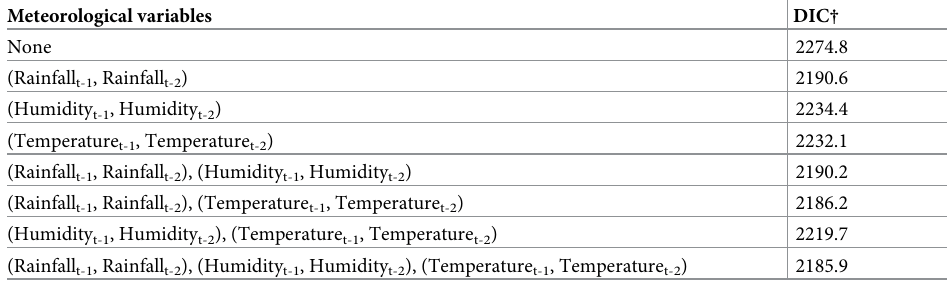
Table 1. Model fit from eight different combinations of the three pairs of meteorological explanatory variables to predict leptospirosis weekly incidence, Salvador, Brazil, 1996–2010. Meteorological variables